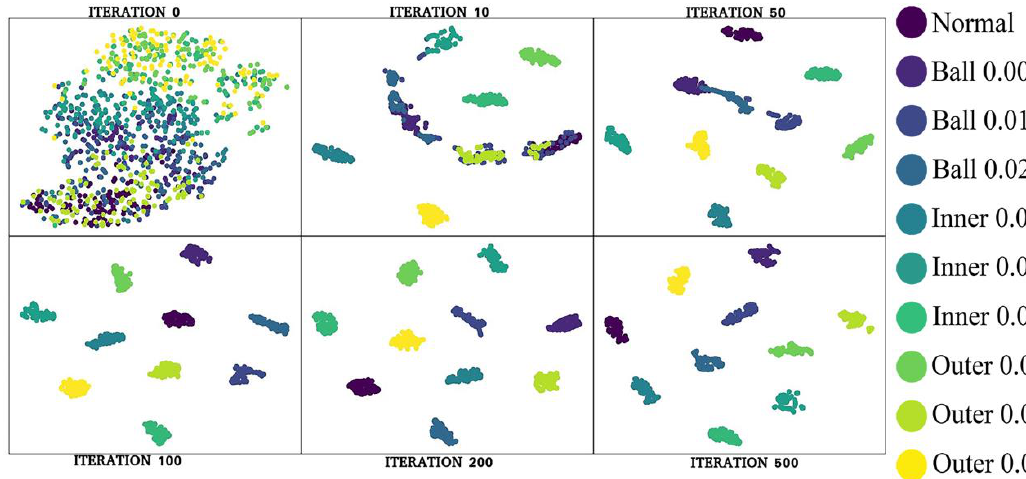
Figure 10. Feature distribution corresponding to the number of iterations.